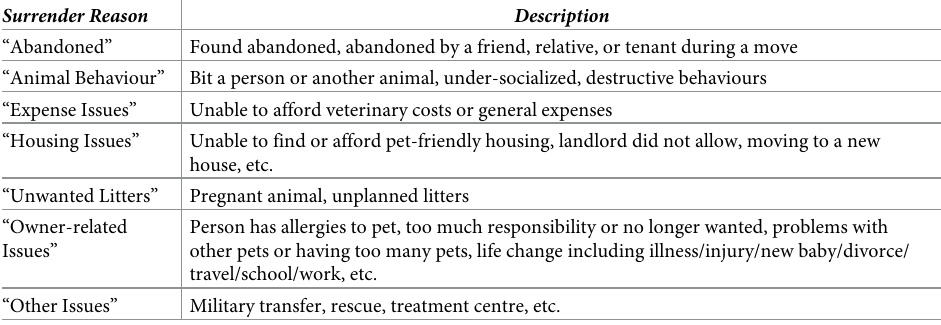
Table 1. The reason for relinquishment of rats and the